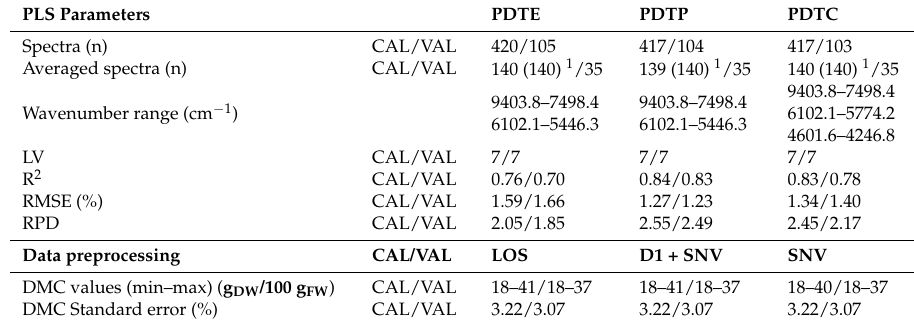
Table 1. Partial least square values of dry matter content prediction. PDTE: entire and unpeeled potatoes, PDTP: entire and peeled potatoes; PDTC: potatoes cut transversally. PLS Parameters